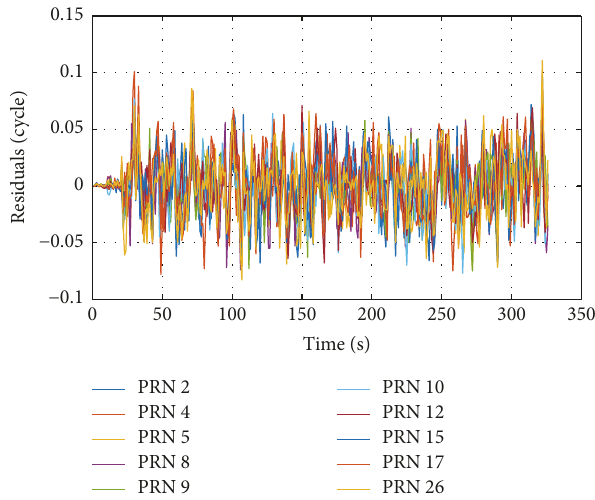
Figure 10: Single difference of carrier phase between 47dB-Hz and 19dB-Hz data sets with the joint VPLL.